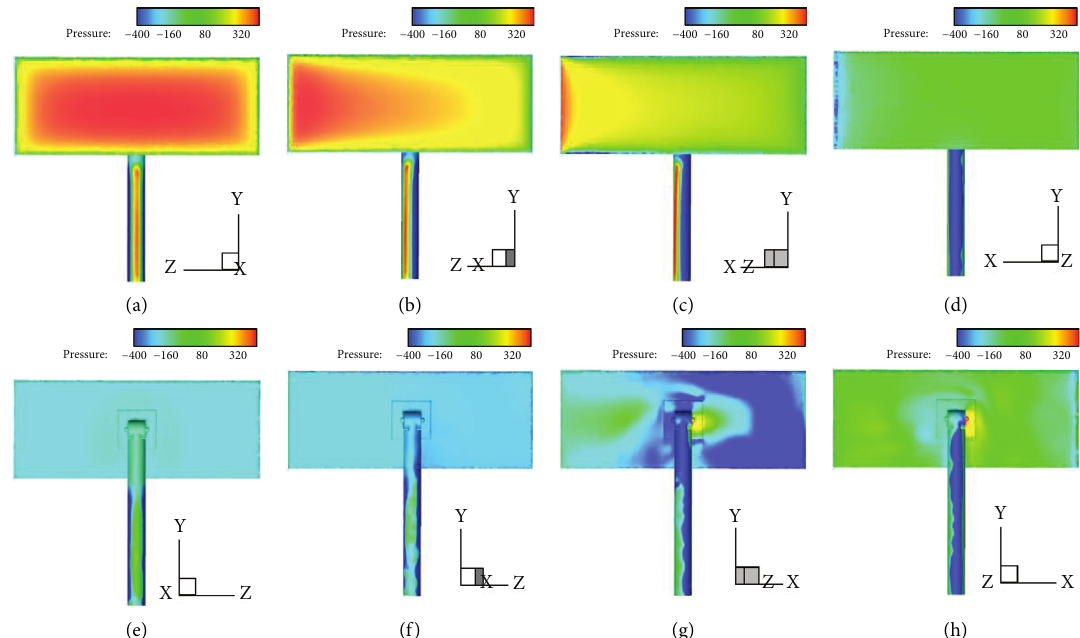
Figure 11: Nephogram diagram of pressure distribution on the front and back of the antenna. (a)–(d) The front of the antenna; (e)–(h) the back of the antenna. (a) β � 0 ° , (b) β � 30 ° , (c) β � 60 ° , (d) β � 90 ° , (e) β � 0 ° , (f) β � 30 ° , (g) β � 60 ° , and (h) β � 90 °